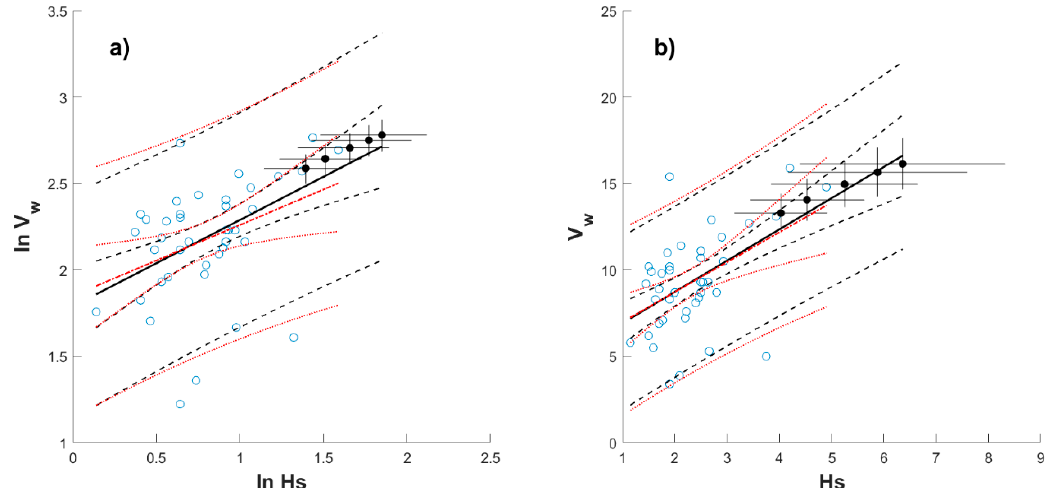
Figure A4. Regression lines and confidence intervals including (solid and dashed lines, respectively) and excluding (dashed–dotted and dotted lines, respectively) T -yr values for May; ( a ) and ( b ) for logarithmic space and linear space, respectively. Filled circles represent T -yr values with embedded perpendicular lines indicating confidence intervals from GEV models.